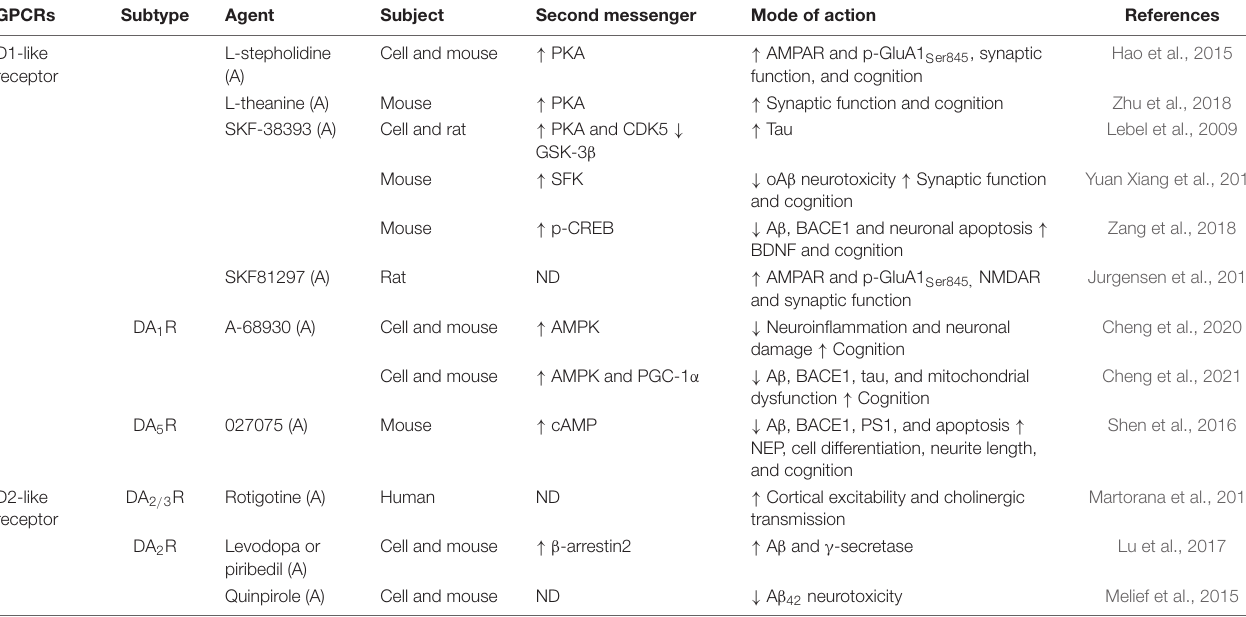
TABLE 4 | Dopaminergic receptors reported to be involved in Alzheimer’s